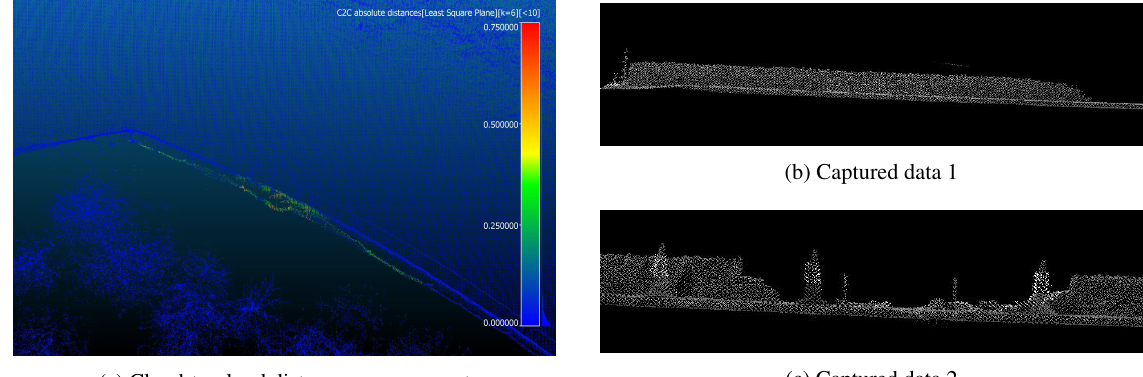
Figure 8: Change detection example showing road-side infrastructure